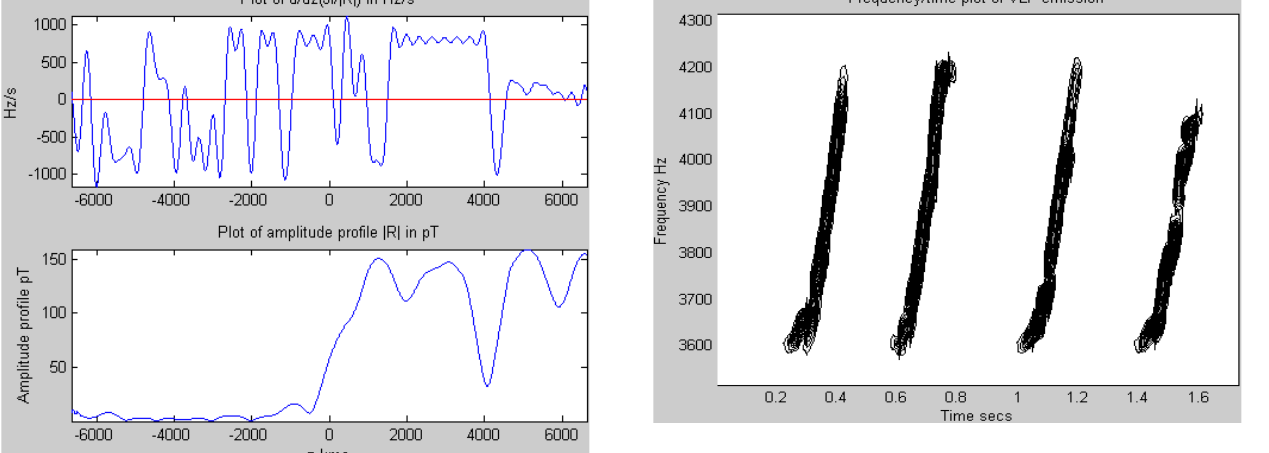
Fig. 15. Fig. 15. Simulated chorus sequence spectrogram for a cold plasma density of N e =20 electrons/cc, with a sweep rate of 4.1kHz/s.